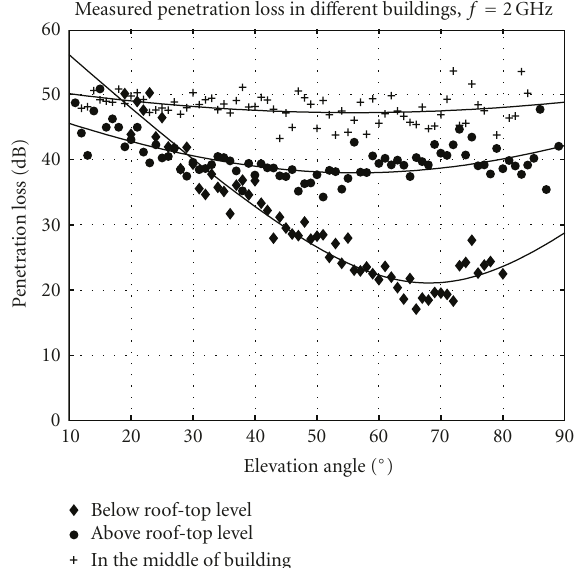
Figure 9: Penetration loss as a function of the elevation angle for di ff erent scenarios at 2.0 GHz.